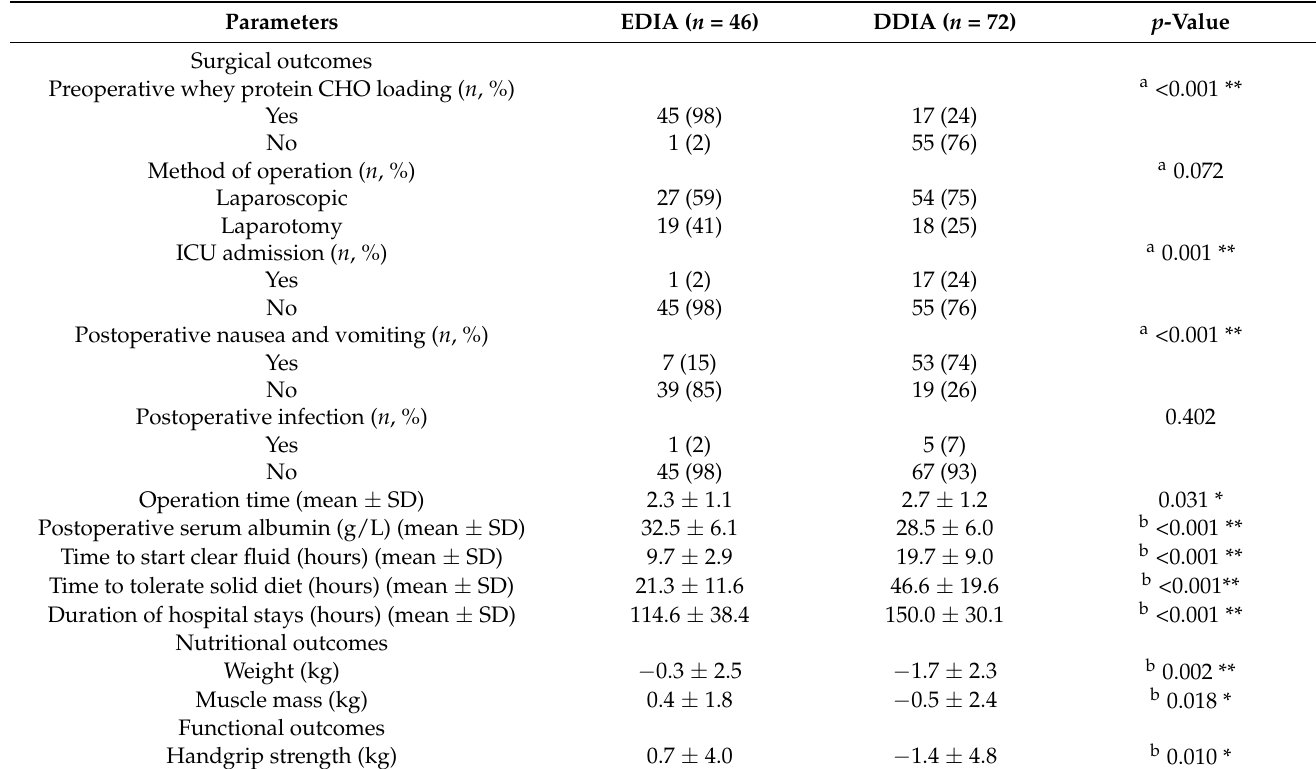
Table 2. Postoperative surgical, nutritional and functional outcomes ( N = 118).